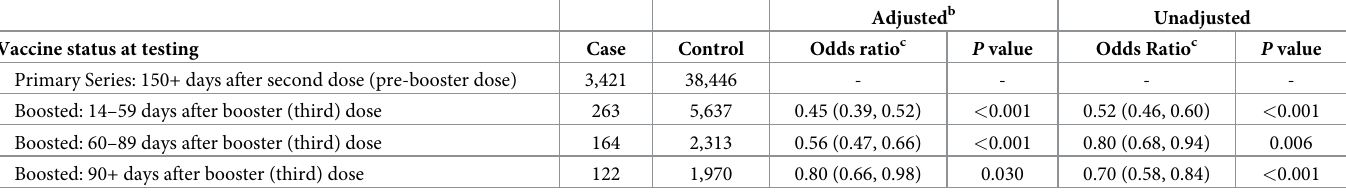
Table 3. Risk of SARS-CoV-2 Omicron (BA.1 lineage) variant infection among people who received booster vaccination relative to booster-eligible people a , accord- ing to time after receiving a booster vaccine